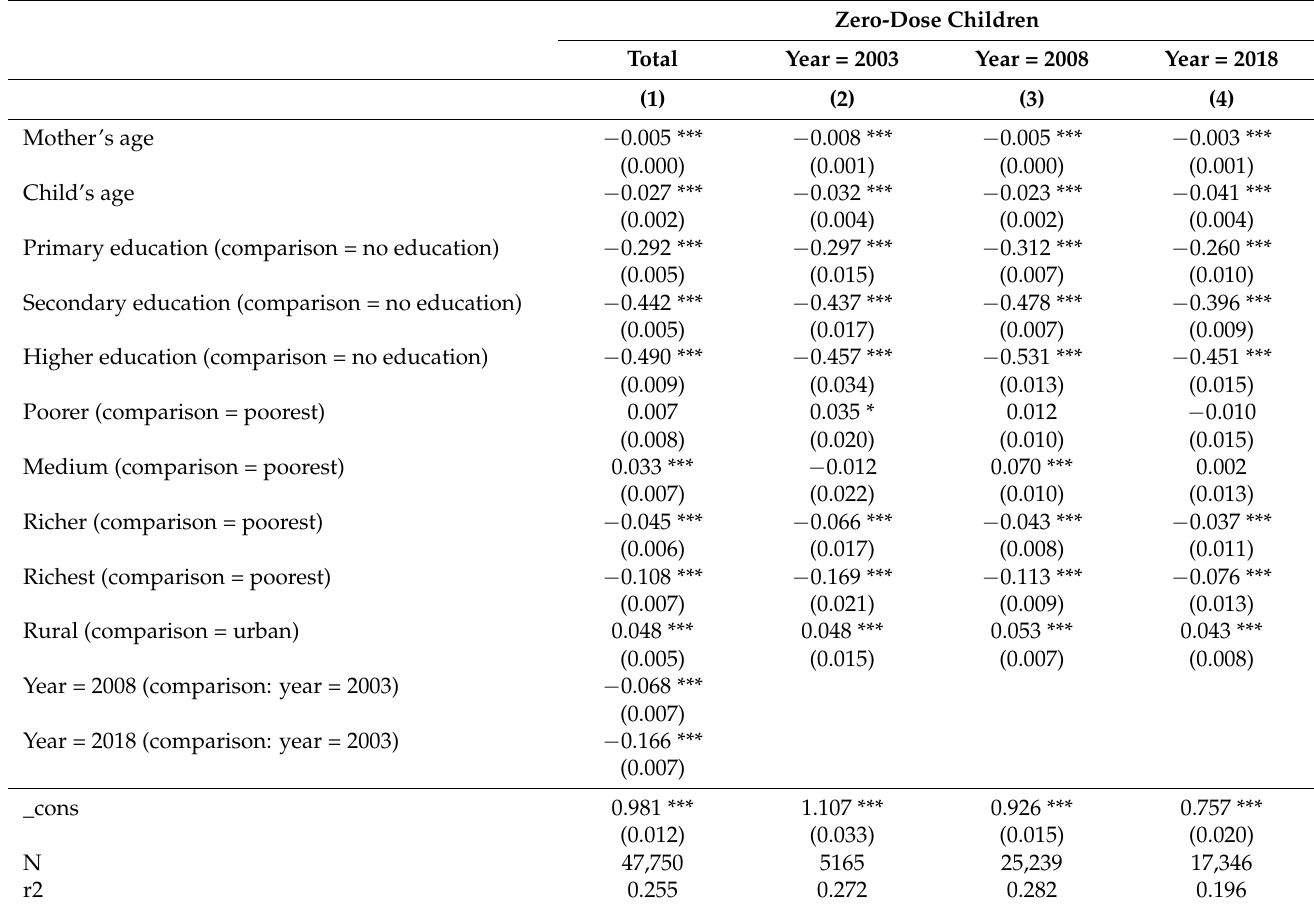
Table 1. Determinants of zero-dose